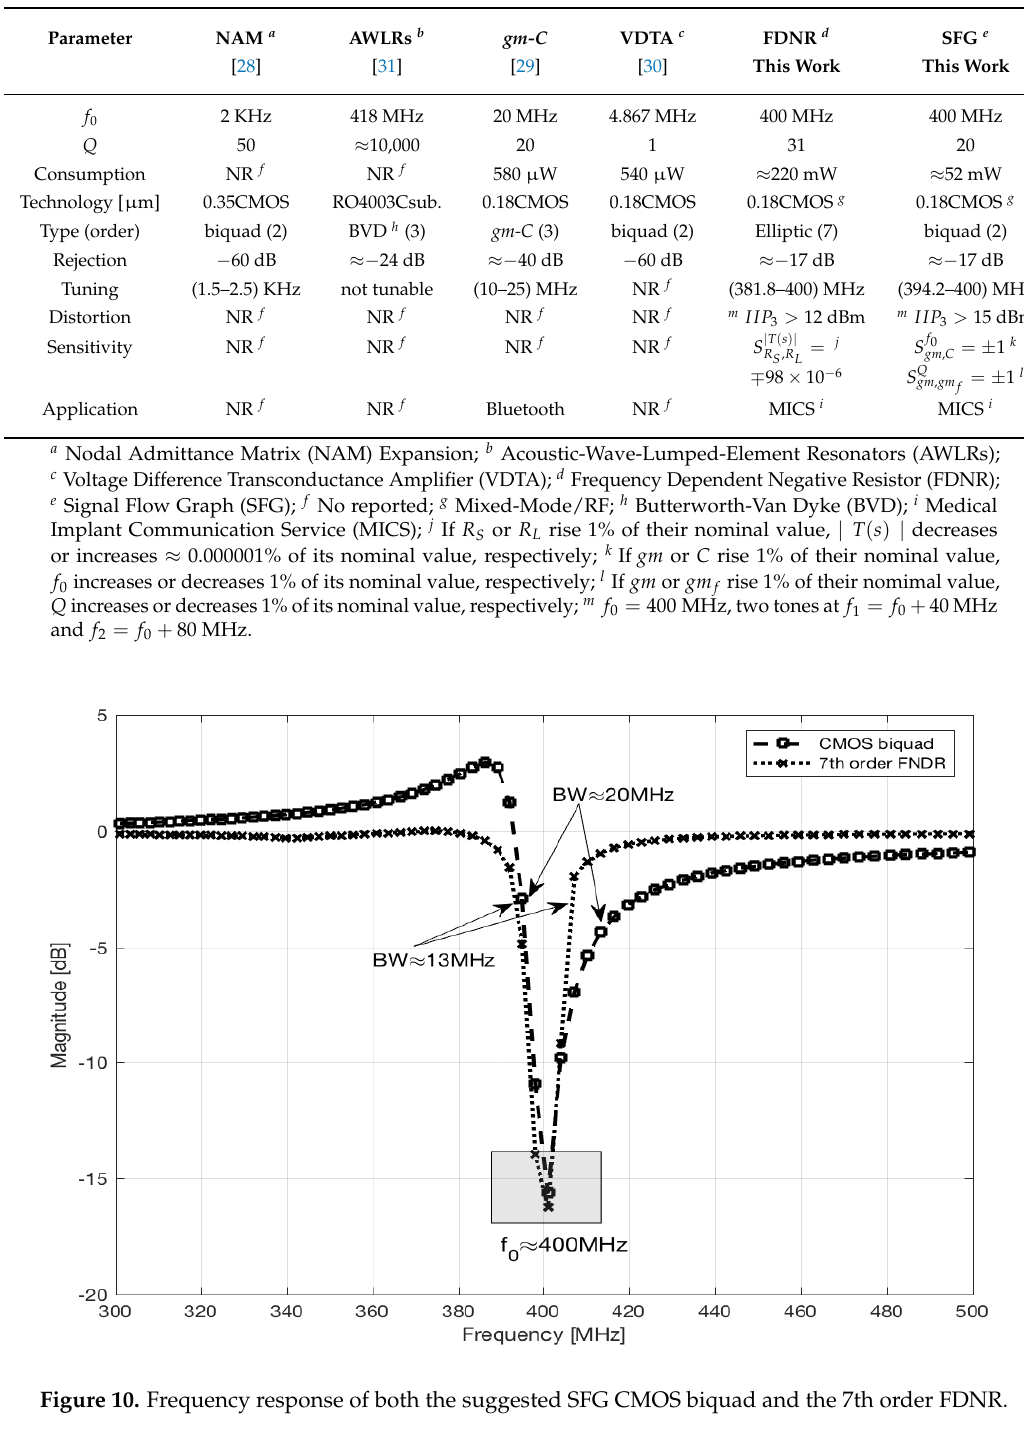
Table 1. Summary of simulation results and performance comparison.